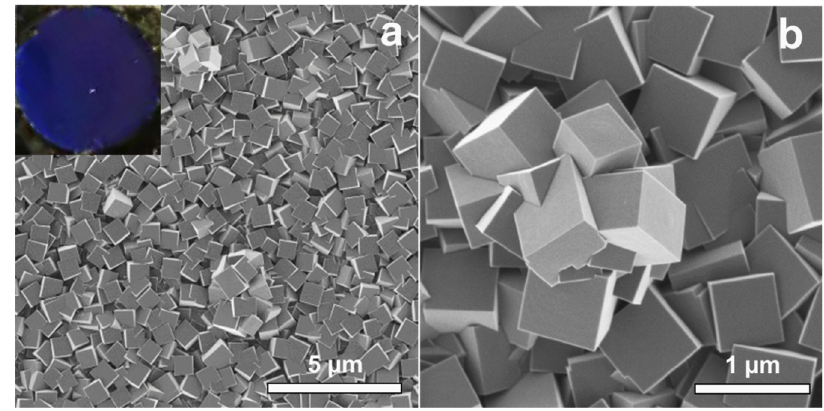
Figure 1. Field emission scanning electron microscope (FEG-SEM) images of electrodeposited Prussian blue (PB) films grown at 0.3 V: ( a ) surface overview, photograph image of the film (inset), ( b ) detailed view of the film surface.